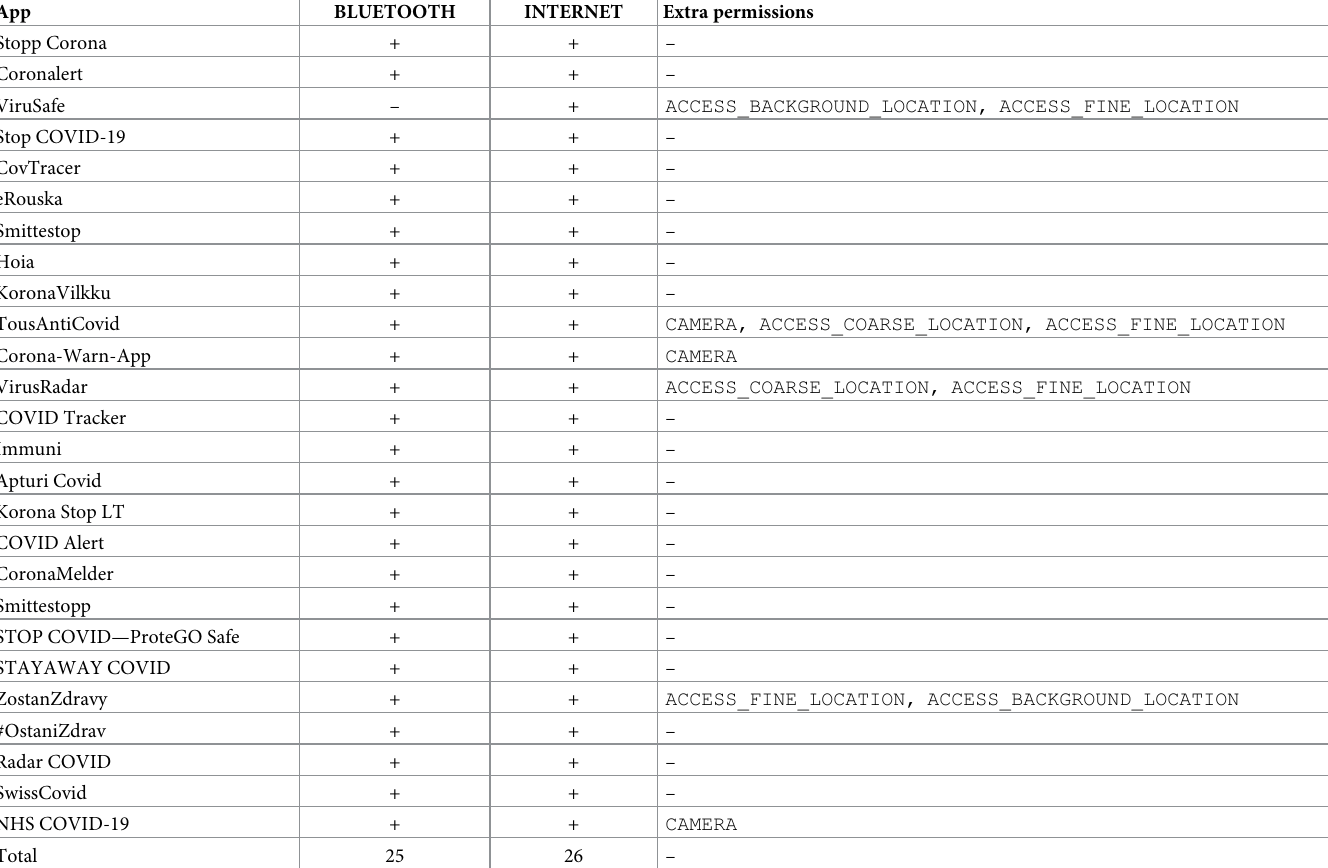
Table 2. Overview of requested permissions per app vis- à -vis the